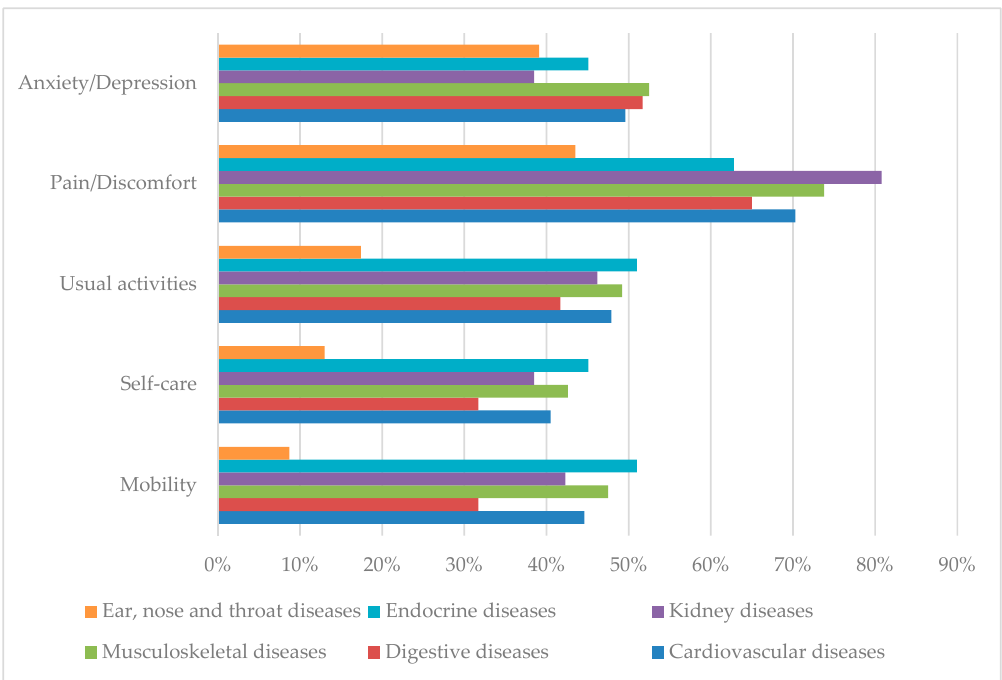
Figure 1. Proportion of patients reporting any problems in the Euroqol-5 dimensions-5 levels (EQ-5D-5L) dimensions by different chronic diseases.